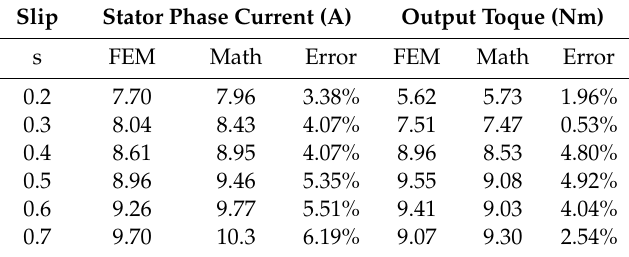
Figure 12. Characteristics of the rotary part: ( a ) Stator phase current; ( b ) Output torque; ( c ) Efficiency; ( d ) Power factor. Table 3. Stator phase current and output torque.